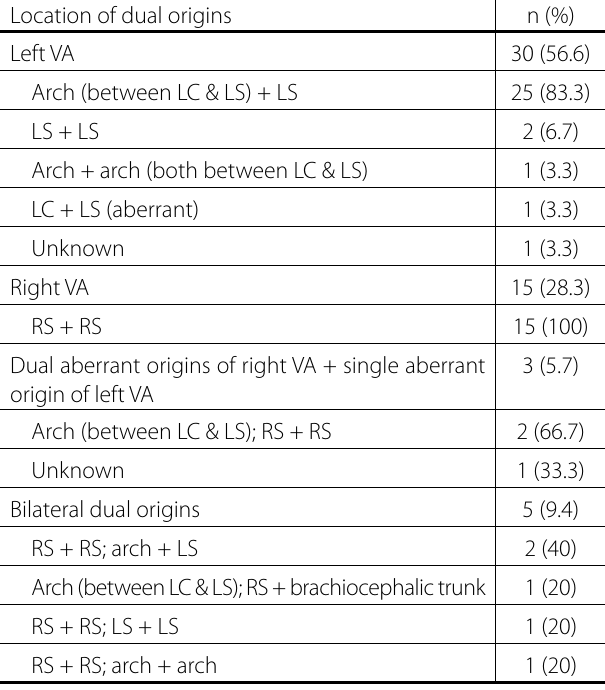
Table 3. Single abnormal origin of vertebral arteries in 1231 cases. Table 4. Location of dual origins of vertebral